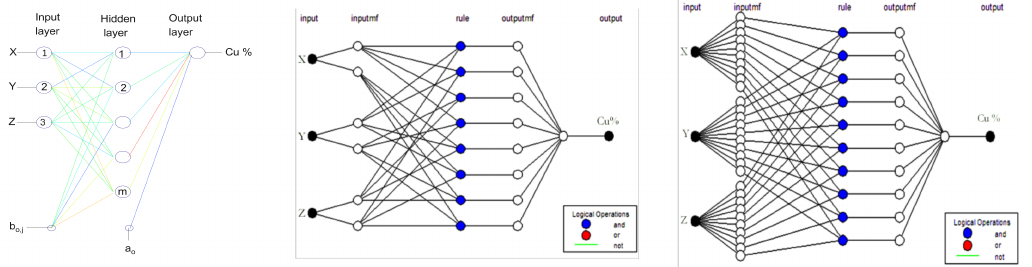
Figure 1. Structure of NN and ANFIS used for ore reserve estimation. ( left ) Multiple-layer feedfor- ward neural network, ( center ) ANFIS generated by grid partition, and ( right ) ANFIS generated by sub